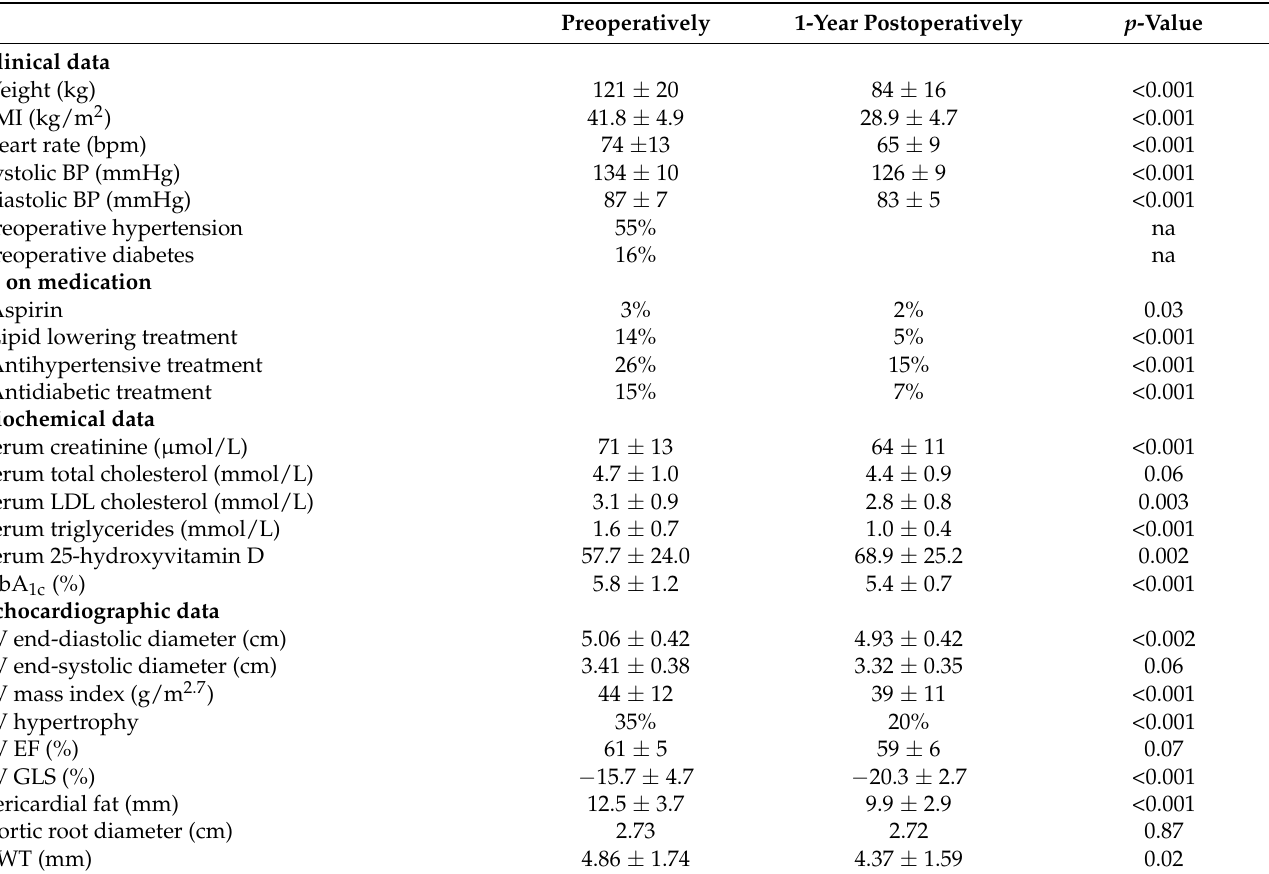
Table 1. Clinical, biochemical and echocardiographic characteristics preoperatively and 1 year after bariatric surgery. Results are presented as mean ± standard deviation or